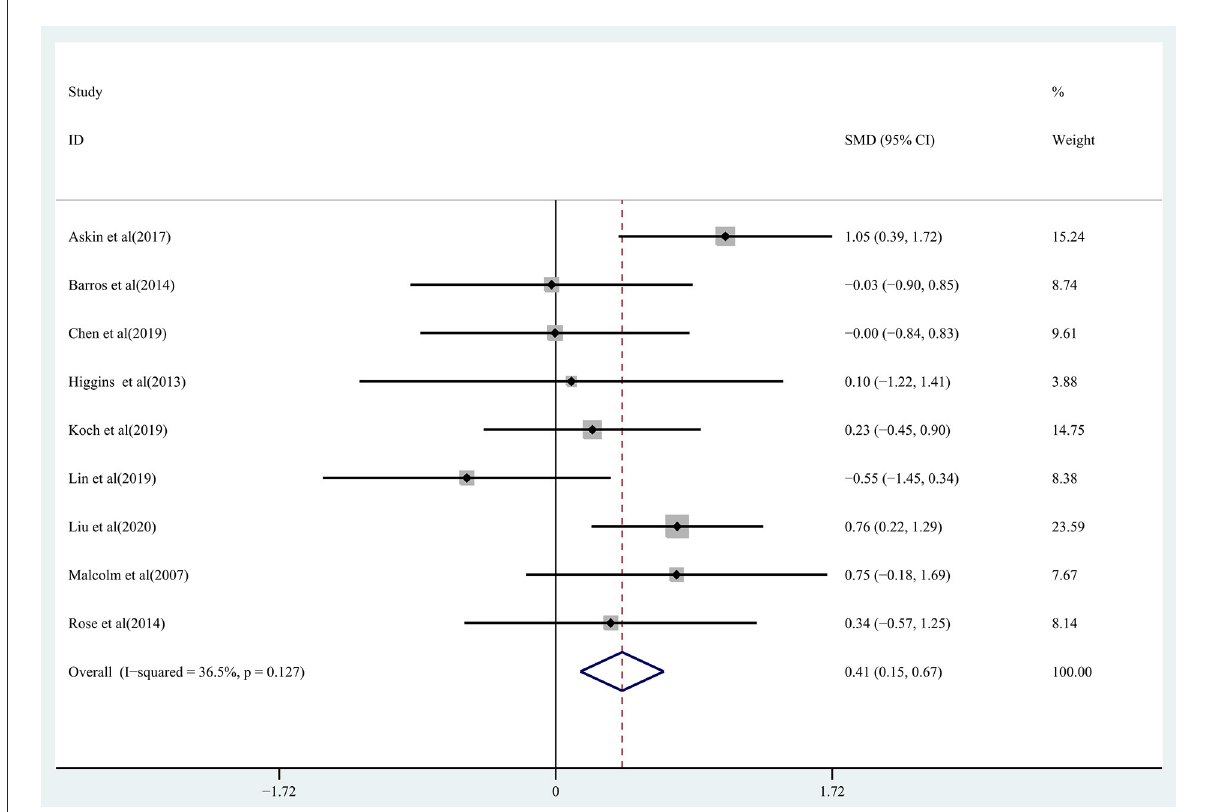
FIGURE9 Forest plot of the effect of rTMS treatment on ADL function recovery in chronic stroke